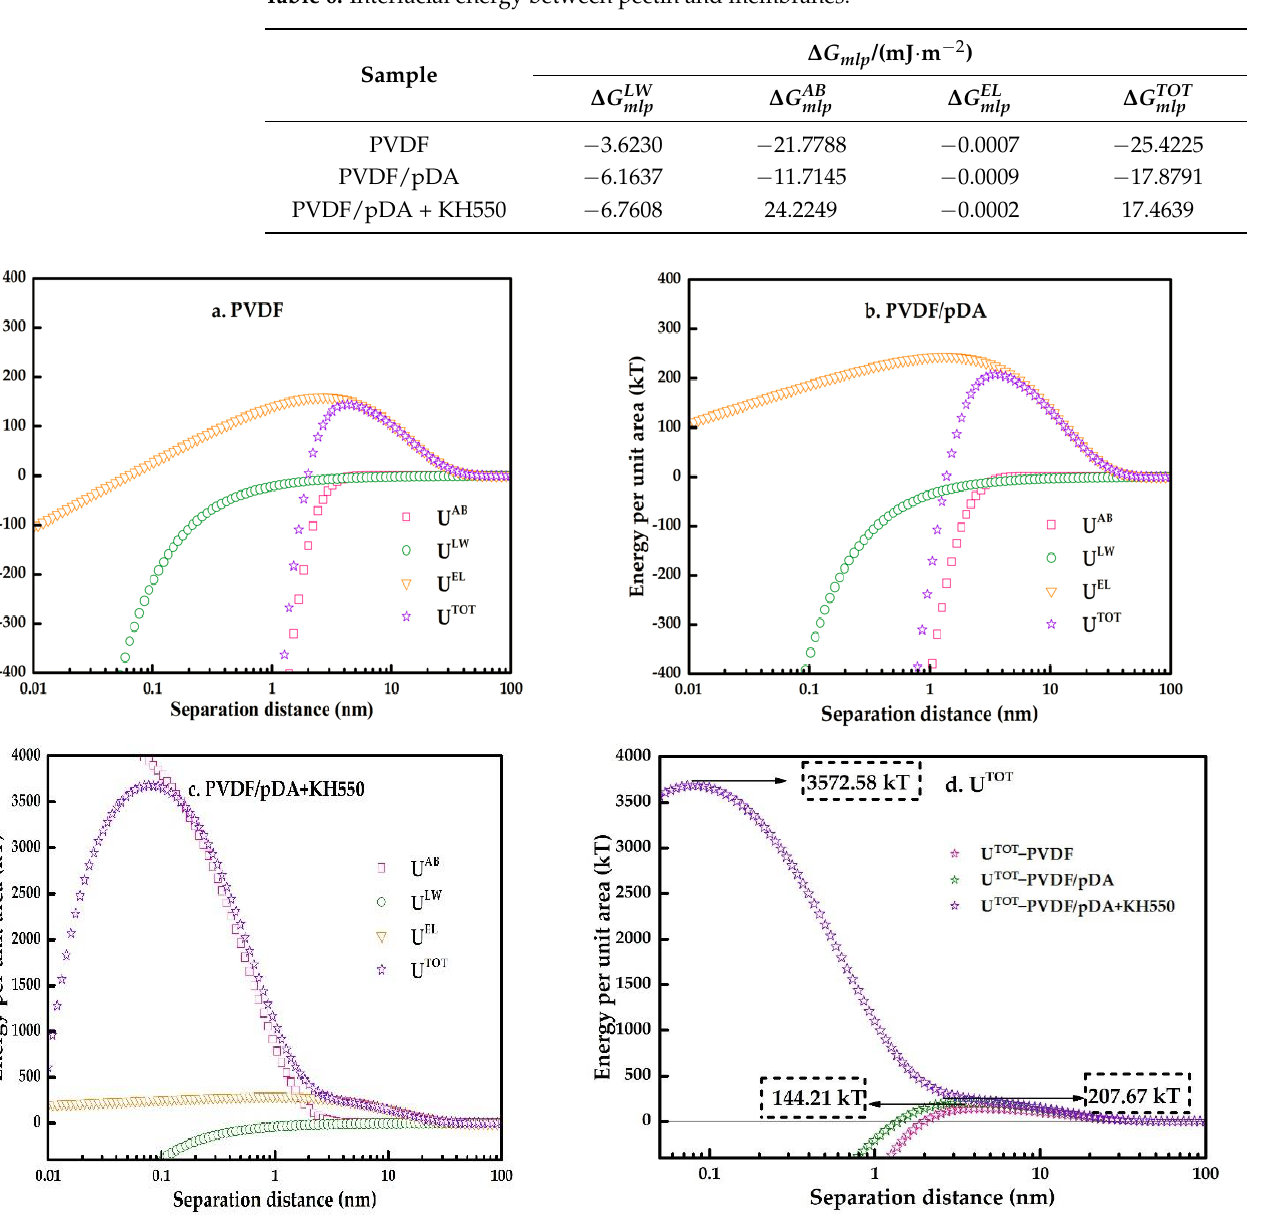
Figure 10. Profiles of specific interactions between the pristine and coated membranes, and the con- taminant, as a function of the separation distance (ns: 1 𝑘𝑇 = 4.115 × 10 −21 𝐽